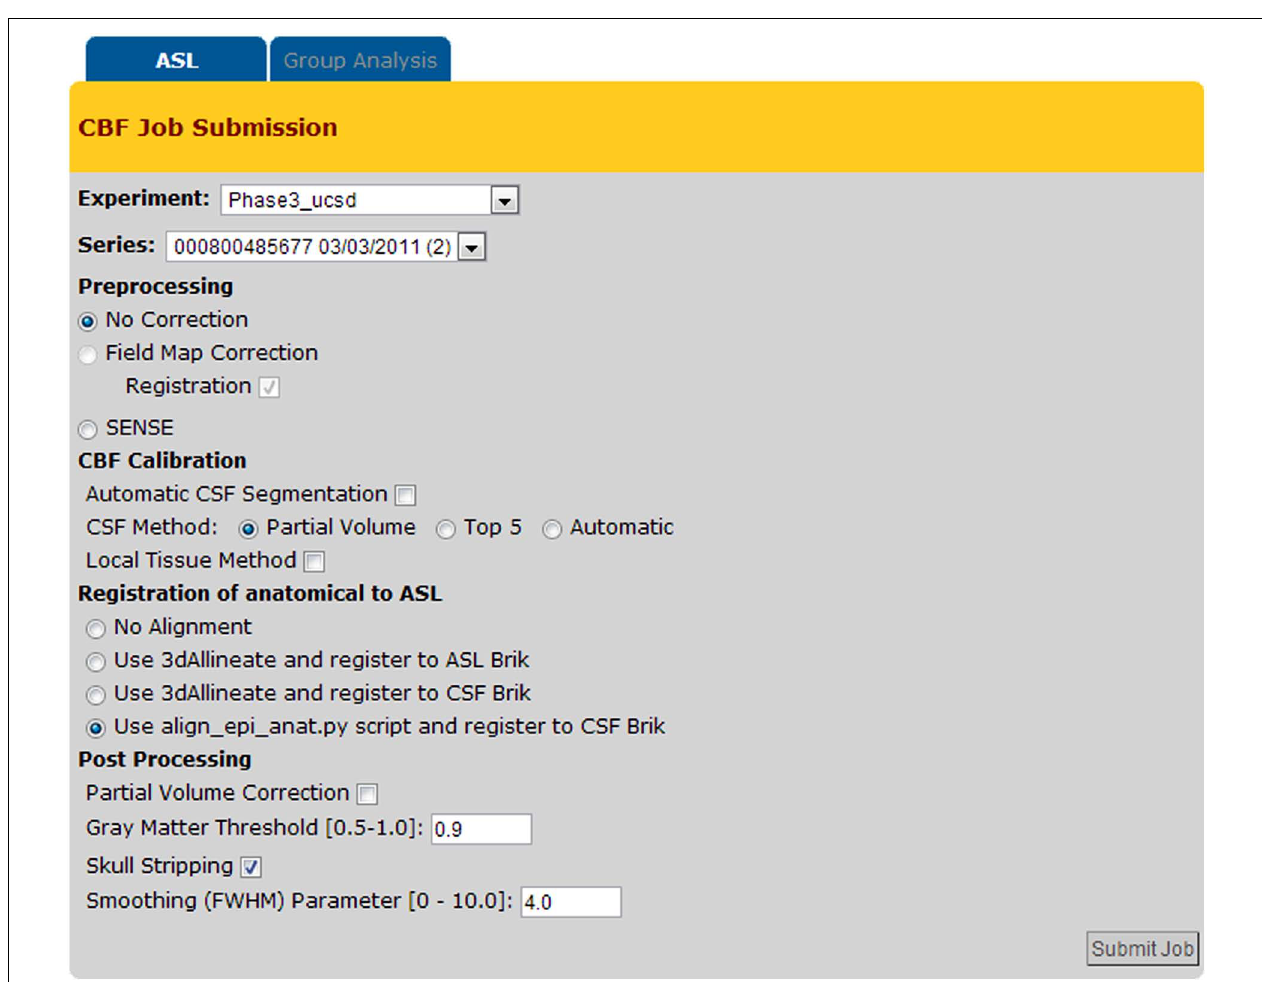
FIGURE 6 | Cerebral blood flow Job Submission page with the list of processing